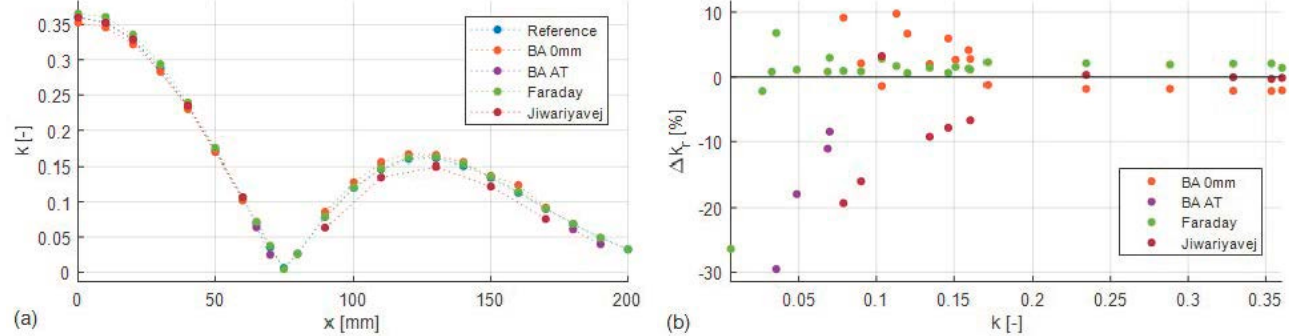
Figure 15. ( a ) Comparison of all tested estimation methods with the reference. ( b ) Relative error of the estimation methods with respect to the reference over k .